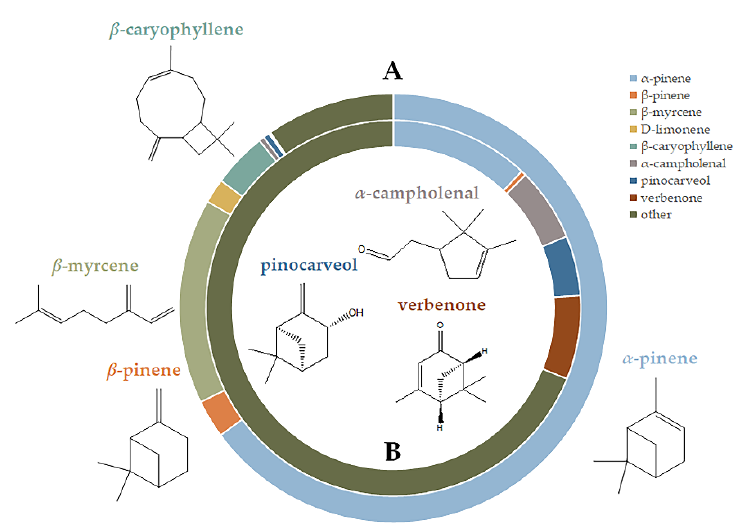
Figure 3. % Content of different volatiles in CMOs obtained from ( A ) fresh and ( B ) 10-year-old